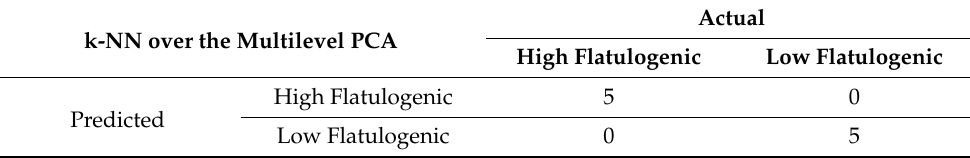
Table 4. Confusion matrix built on the multilevel PCA